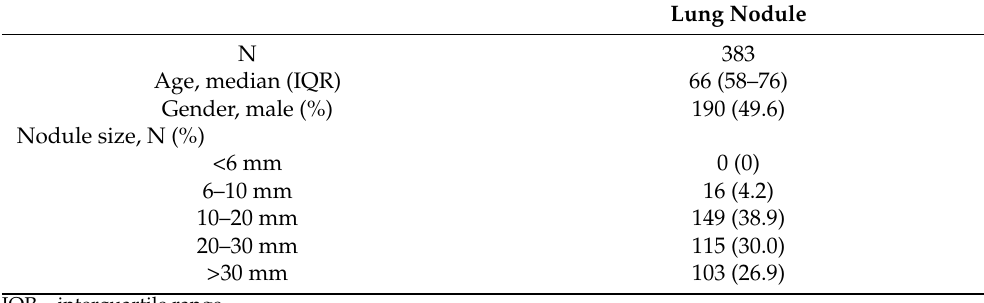
Table 4. Characteristics of the CXRs in temporal analysis.